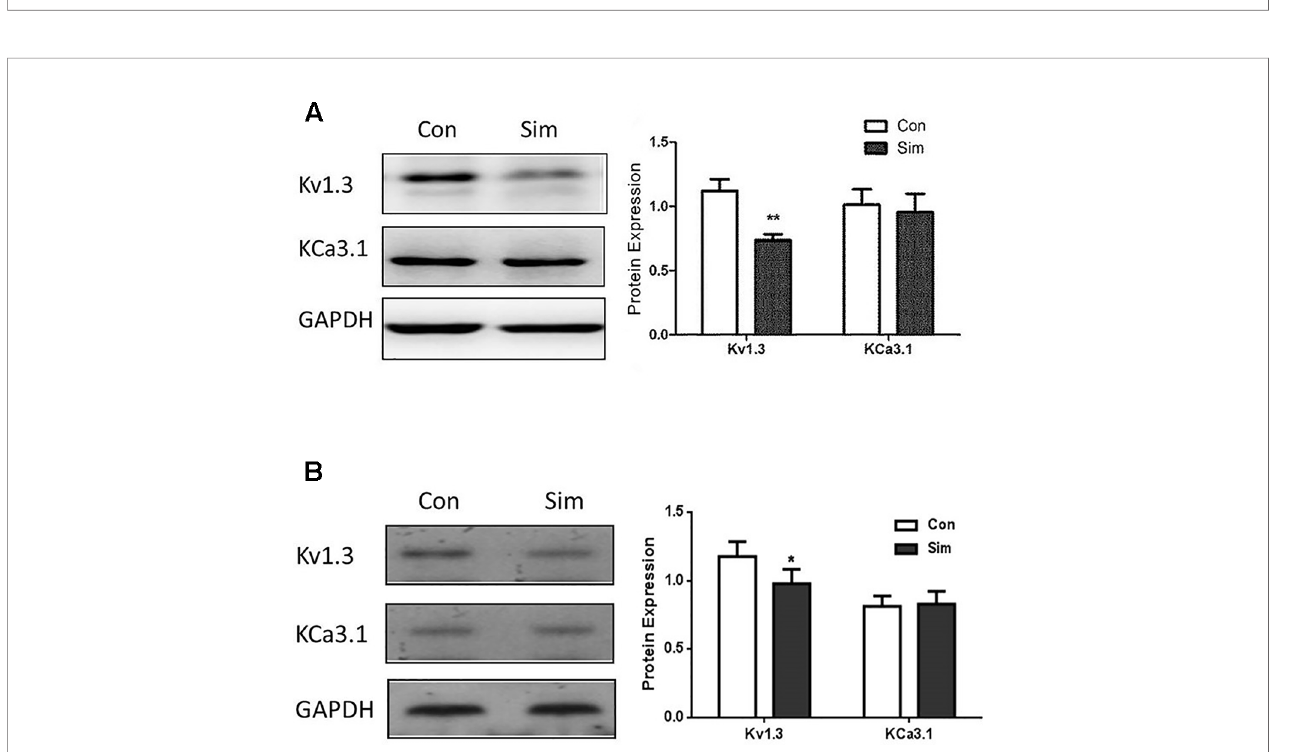
FIGURE 2 | Protein expression levels of Kv1.3 and KCa3.1 in THP-1 cells (A) and PBMCs from CAD patients (B) were measured by western blot, respectively. (A) Representative western blot images of Kv1.3 and KCa3.1 levels in normal (control) and simvastatin treatment groups in THP-1 cells. The results were quanti fi ed, and represent the mean ± SEM, compared to controls (n = 4, ** P < 0.01). (B) Representative western blot images of Kv1.3 and KCa3.1 levels in normal (control) and simvastatin treatment groups in PBMCs from CAD patients. The results were quanti fi ed, and represent the mean ± SEM, compared to controls (n = 4, * P < 0.05).